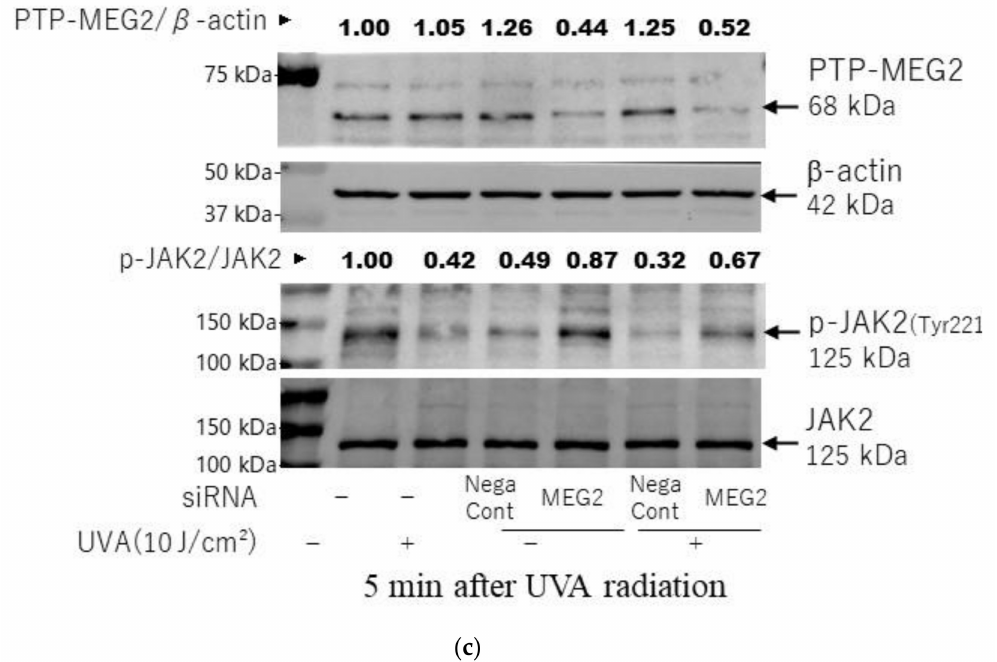
Figure 18. Effects of the transfection of a protein tyrosine phosphatase (PTPMEG2) siRNA on the UVA-induced decrease in the phosphorylation of STAT3 at Tyr 705 and JAK2 at Tyr 221 in HDFs. ( a ) Effect of transfecting a PTPMEG2 siRNA on the expression level of PTPMEG2 mRNA in UVA- or non-exposed HDFs at 3 h post-irradiation. Cell lysates were prepared at 3 h post-irradiation and were subjected to RT-qPCR analysis as described in the Materials and Methods section. Data represent means ± SD., n = 3, ** p < 0.01. ( b ) Effect of transfecting a PTPMEG2 siRNA on the expression level of PTPMEG2 protein and the phosphorylation level of STAT3 (Tyr705) and ERK in UVA- or non-exposed HDFs at 15 min post-irradiation. ( c ) Effect of transfecting a PTPMEG2 siRNA on the expression level of PTPMEG2 protein and the phosphorylation level of JAK2 (Tyr221) in UVA- or non-exposed HDFs at 5 min post-irradiation. Representative immunoblots from three independent experiments are